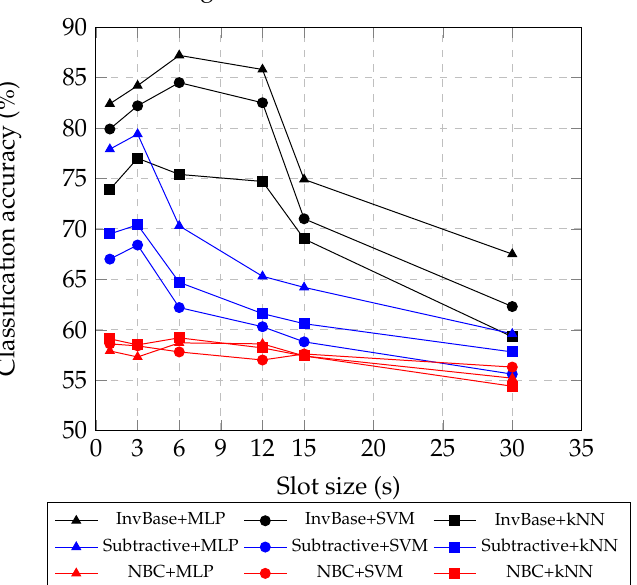
Figure 5. Valence classification accuracies obtained using different slot sizes in InvBase, subtractive, and NBC